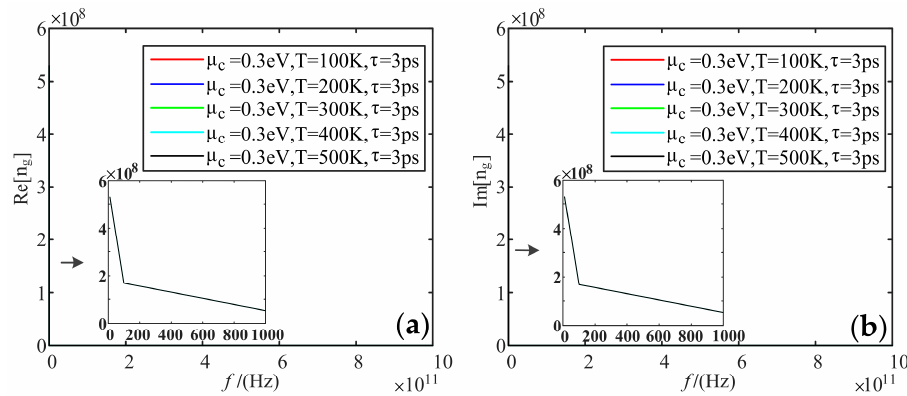
Figure 11. Variation curve of the refractive index of graphene with frequency at different temperatures: ( a ) real part; ( b ) imaginary part.